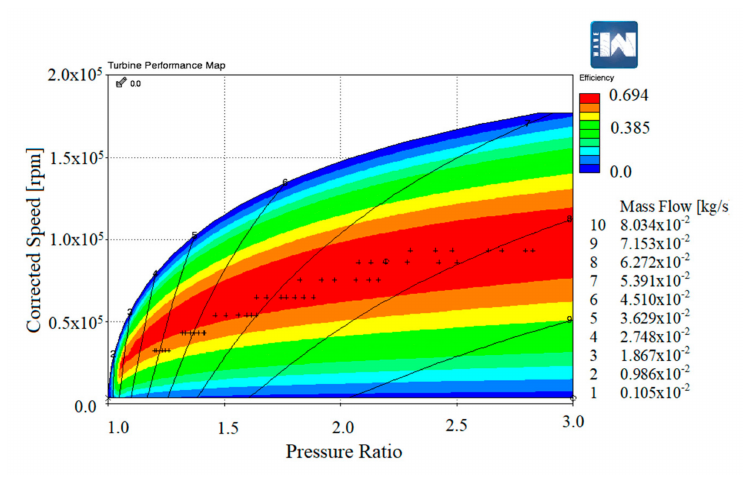
Figure 10. Scaled turbine map.